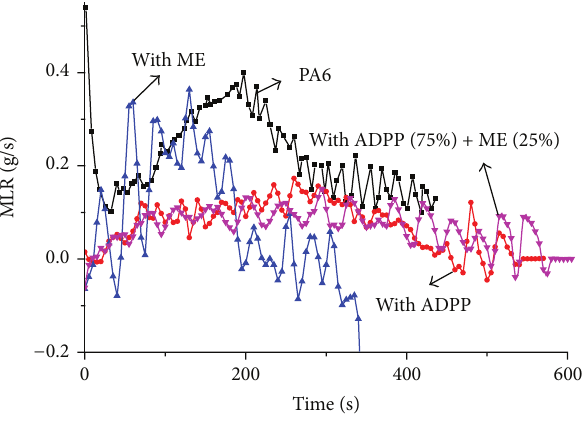
Figure 1: HRR curves of PA6 and flame-retarded PA6. Figure 2: MLR curves of PA6 and flame-retarded PA6.